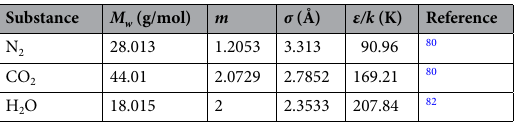
Table 3. PC-SAFT EOS factors for the substances utilized in this paper.